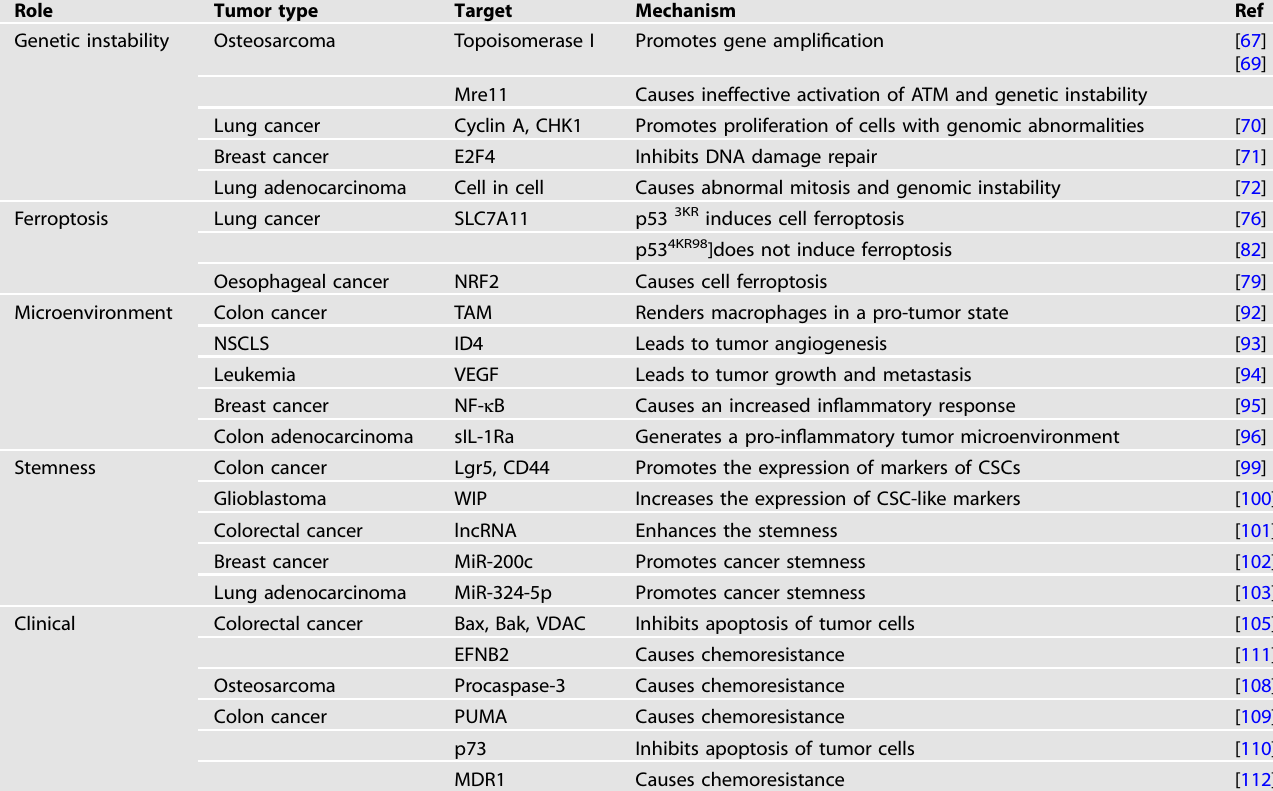
Table 1. The function of mutp53 and the corresponding regulatory